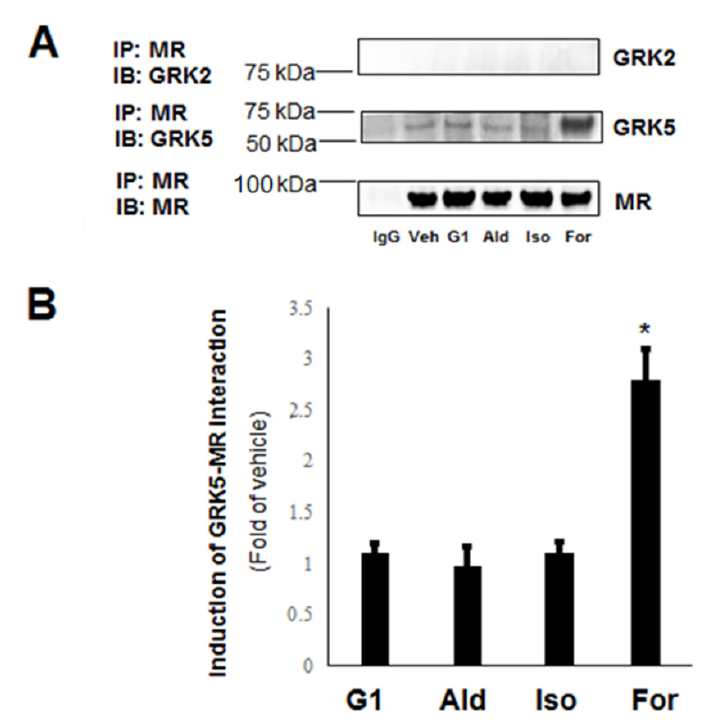
Figure 1. Interaction of G protein-coupled receptor (GPCR)-kinase (GRK)-5 but not GRK2 with the mineralocorticoid receptor (MR) in cardiac myocytes and the role of β -adrenergic receptors (ARs): ( A ) Immunoblotting for GRK2 and GRK5 in MR immunoprecipitates from H9c2 cardiomyocyte extracts prepared after 15-min-long treatments with vehicle (dimethylsulfoxide—DMSO, Veh), 100 nM G1, 100 nM aldosterone (Ald), 10 µ M isoproterenol (Iso), or 10 µ M formoterol (For). Blots for MR are also shown to confirm equal amounts of receptor immunoprecipitated. IP: immunoprecipitation; IB: Immunoblotting; IgG: Negative control for the co-IP (general rabbit IgG was used in the IP instead of an anti-MR antibody). Representative blots are shown in ( A ) and the relative densitometric quantitation of five independent experiments done in duplicate is shown in ( B ). * p < 0.05, vs. any other treatment; n = 5.